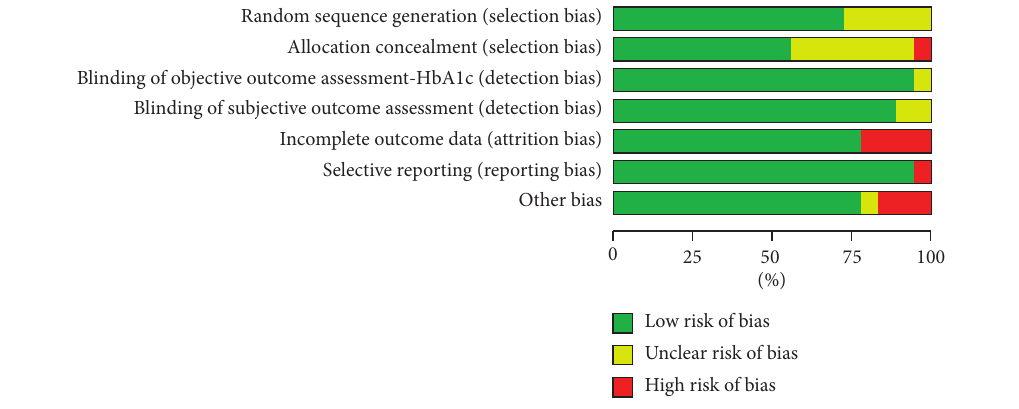
Figure 2: Risk of bias assessment across all included